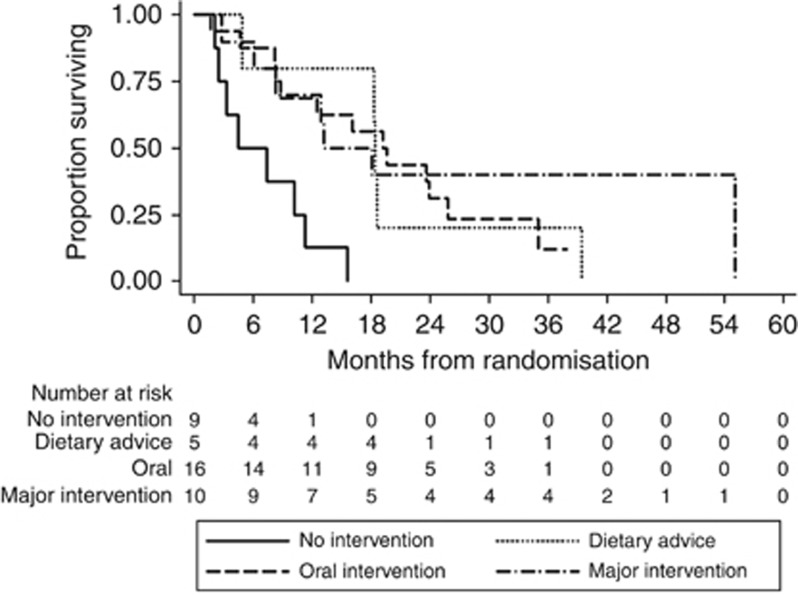
Kaplan-Meier curve of overall survival for patients with baseline NRI<100 according to nutritional intervention received at baseline (log-rank P=0.001). Abbreviation: NRI, nutritional risk index.